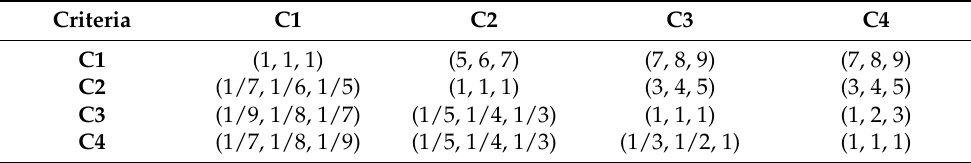
Figure 4. Criteria linguistics comparison. Table 7. Main criteria fuzzy pairwise comparison matrix.